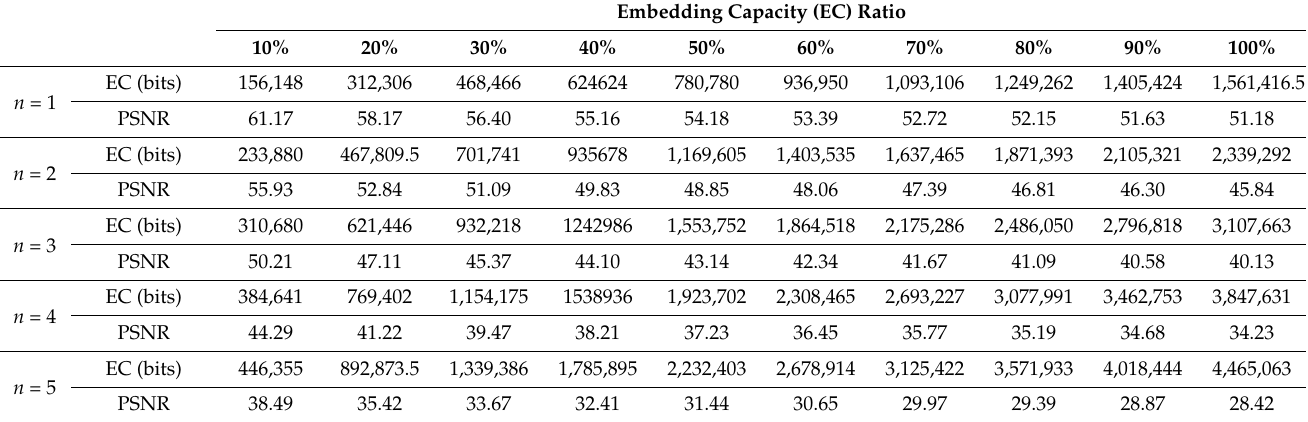
Table 8. Comparison of average P, EC and PSNR values for n = 1 to 5 in all colored images used in experimental studies.